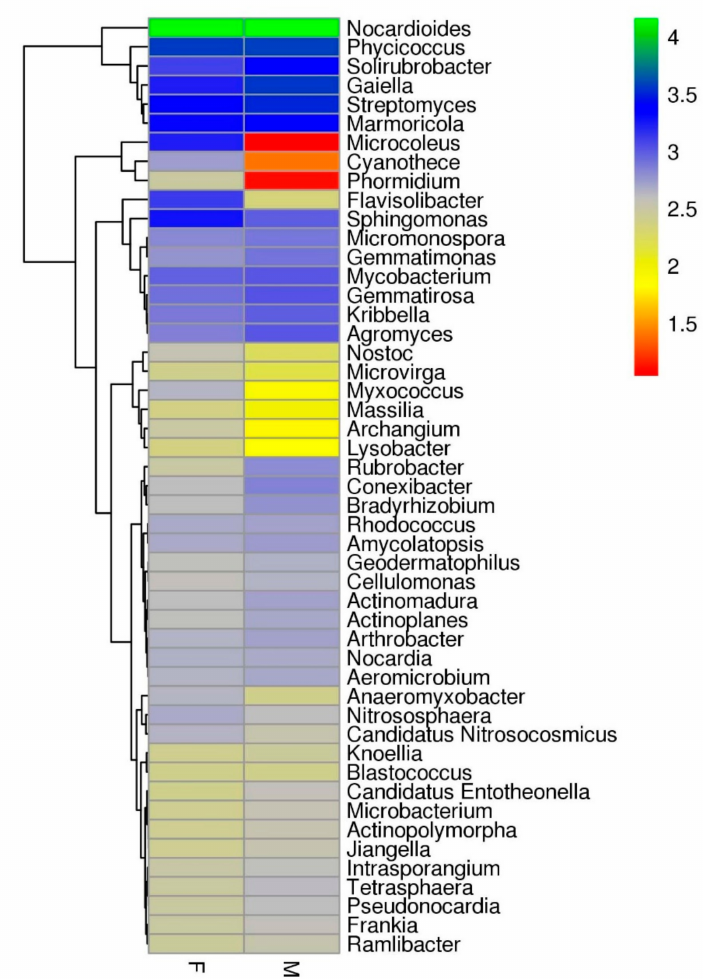
Figure 3. Relative abundance of the top 50 common bacterial genera within microbial communities sampled from lentil cultivars Moitree (M) and Farmer-2 (F) using R package Pheatmap.